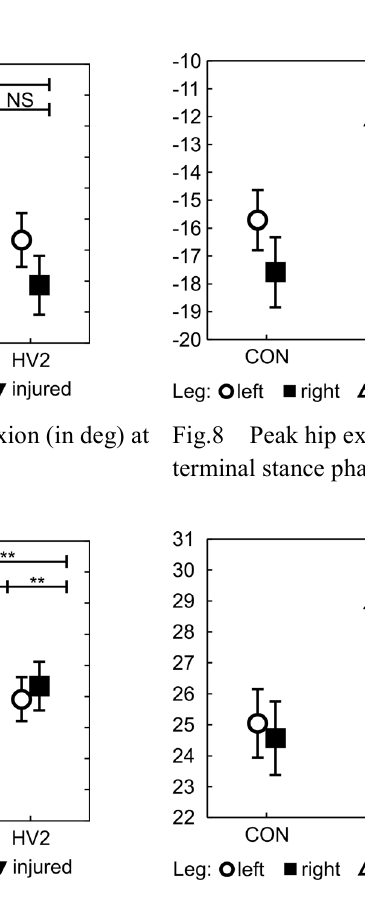
Fig.9 Peak knee flexion (in deg) at initial swing phase 3.2 Subjects with one-sided